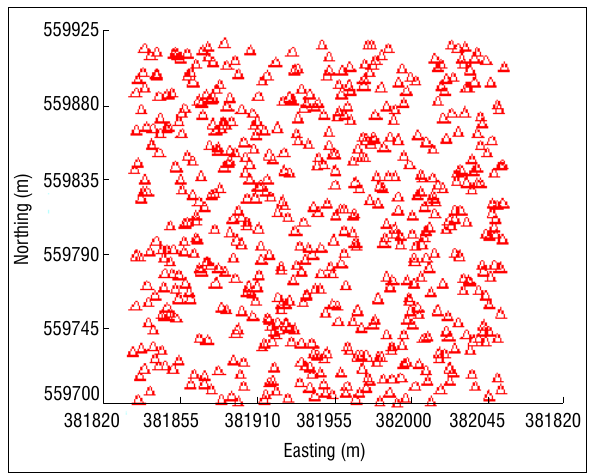
Figure 2: UTM coordinates of the sampled points in the study area. The stratified random sampling was used to select the training data. The spatial dependency of the observed data was examined by plotting its semivariances against the lag distance to produce a semivariogram (Figure 3). The calculated nugget was 0.6. The range was 70, while the sill was 29.6. Beyond the range value the data are spatially independent, whereas the data within the range area are spatially dependent. The nugget value of 0.6 indicated that the error in observation was minimal. The sill value of 29.6 indicated the maximum value of the semivariance that corresponded to the range